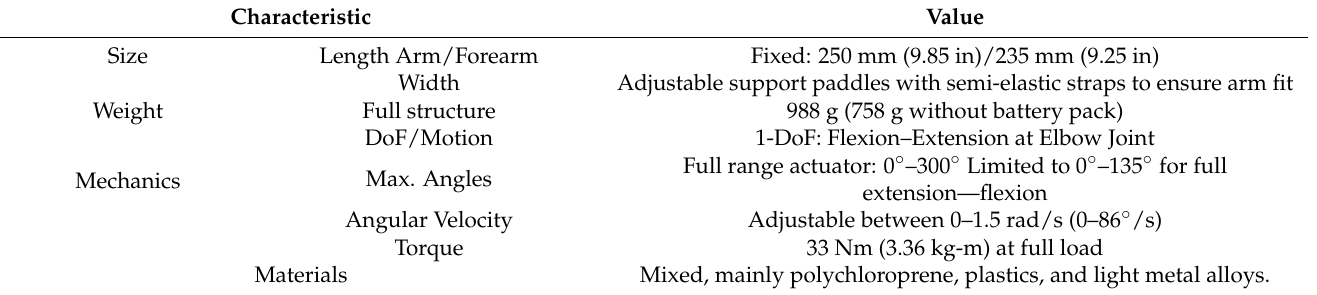
Table 1. Summary of the physical and mechanical characteristics of the exoskeleton prototype.